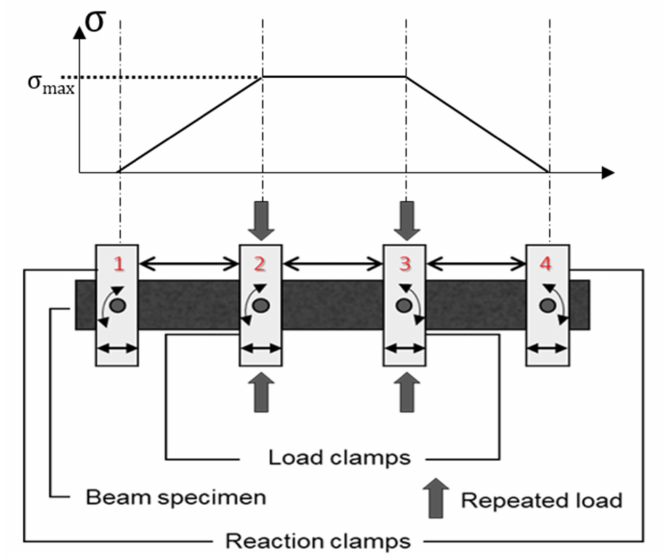
Figure 3. Scheme and tensile stress distribution of 4PB fatigue